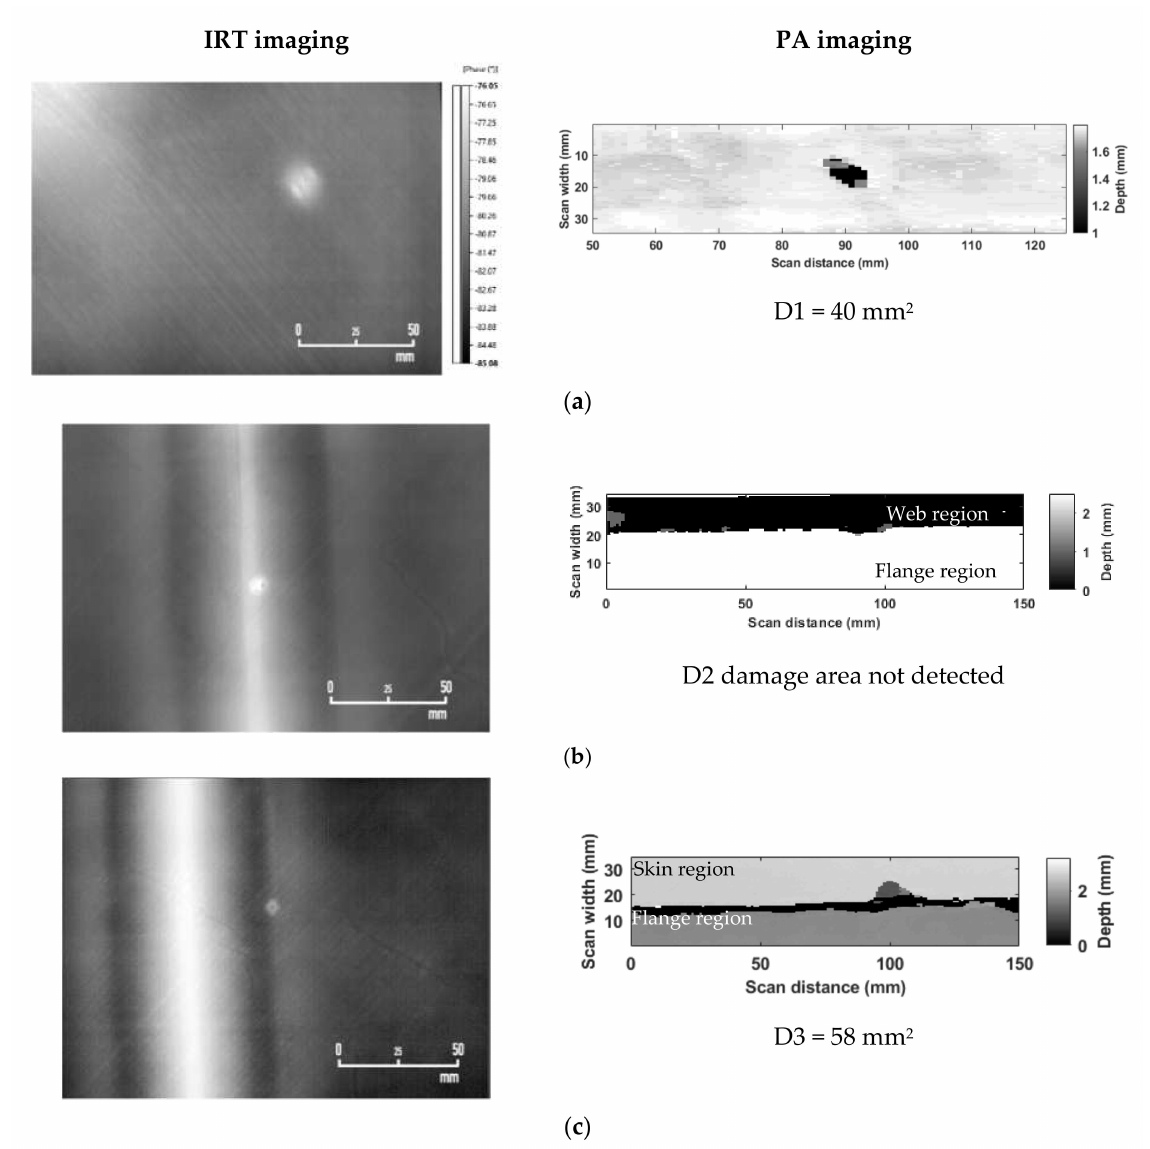
Figure 7. Comparison of IRT and PA imaging for the impact damages (D1, D2, and D3) on the stiffened panel collected using the IRT and PA module on the robot. ( a ) Skin region ( b ) web (T junction) region and ( c ) boundary of the skin-flange